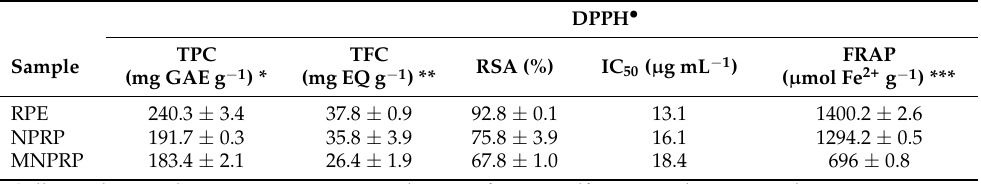
Table 2. The total content of phenols (TPC) and flavonoids (TFC) of RPE, NPRP, and MNPRP by the Folin–Ciocalteu method, aluminum chloride method, and antioxidant activity by DPPH and FRAP